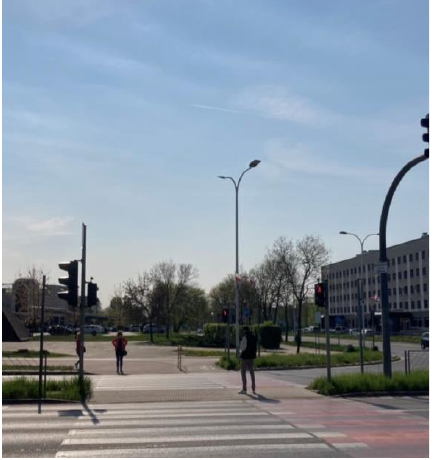
Figure 9. Observation site: pedestrian crossing number 1.